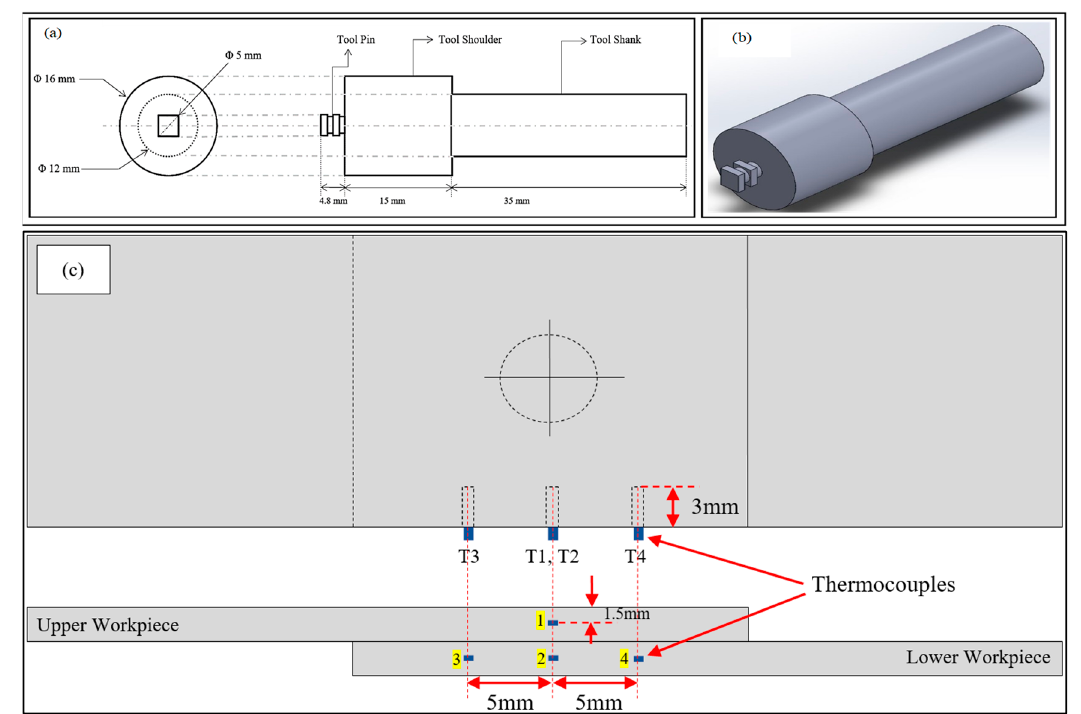
Figure 4. ( a ) Schematic of the FSSW tool; ( b ) 3D view of the FSSW tool; ( c ) thermocouple positions. Table 2. Process parameters and experimental